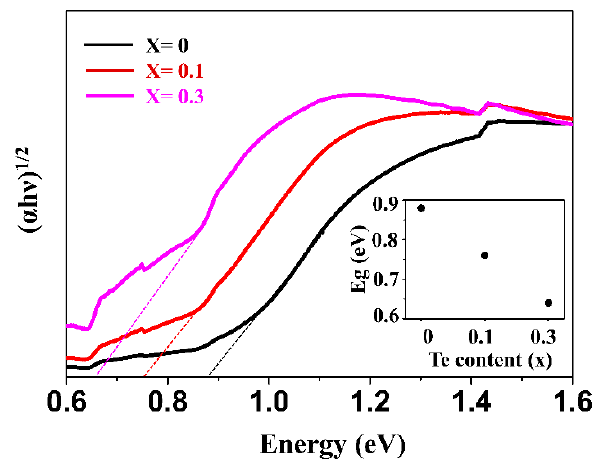
Figure 5. ( α hv ) 1 / 2 versus ( h ν ) plots of the polycrystalline SnSe 1 − x Te x (x = 0, 0.1 and 0.3) obtained by UV-Vis-NIR spectrum. The inset shows the optical band gap versus Te content. The band gap value for each sample was obtained by extrapolating these plots to the x-axis.